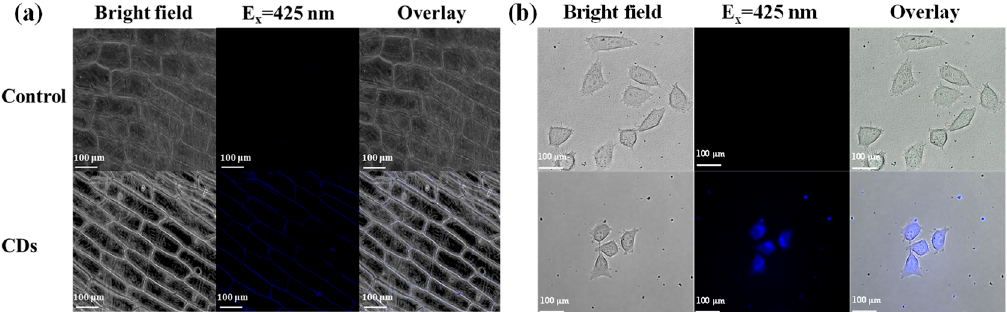
Figure 7. Image of ( a ) onion epidermal cells treated in 180-CDs for 10 min, ( b ) HepG2 cells treated with 180-CDs for 24 h. Cells without CDs treatment were used as control.